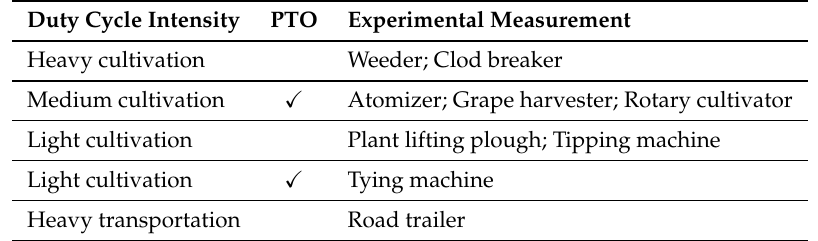
Table 1. Working conditions for a specialized tractor. These are divided into groups based on the duty cycle intensity and Power Take Off PTO requirements. Traction is required for all the operations